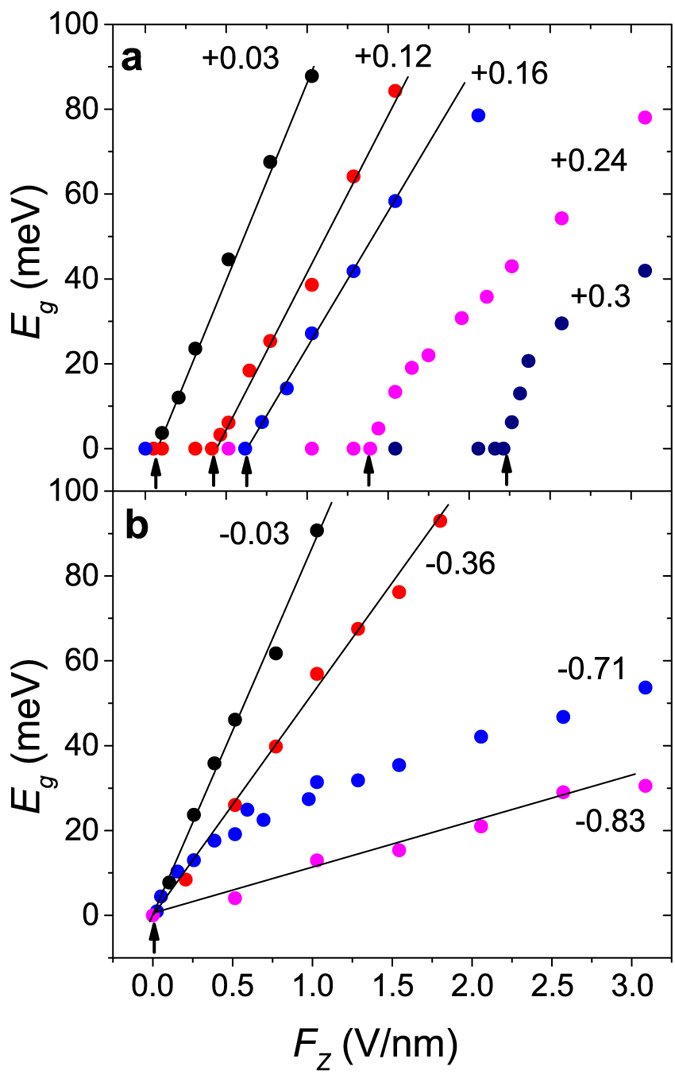
Electric field-induced band gap as a function of electric field .(a) When the layer slides along the path from the AB to the AA′ stacking (ds > 0). (b) When the layer slides along the path from the AB to the AA stacking (ds < 0). Numbers indicate ds in units of  and arrows indicate the critical field Fc required for the band gap opening. The straight lines are the linear fits as described in the text.